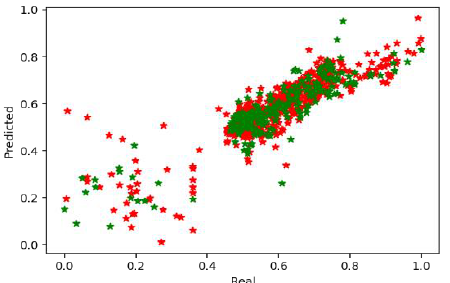
Figure 9. Plot of real and predicted train data (red stars) and test data (green stars). Real depth values are indicated on the abscissae and the predicted values in the ordinates.